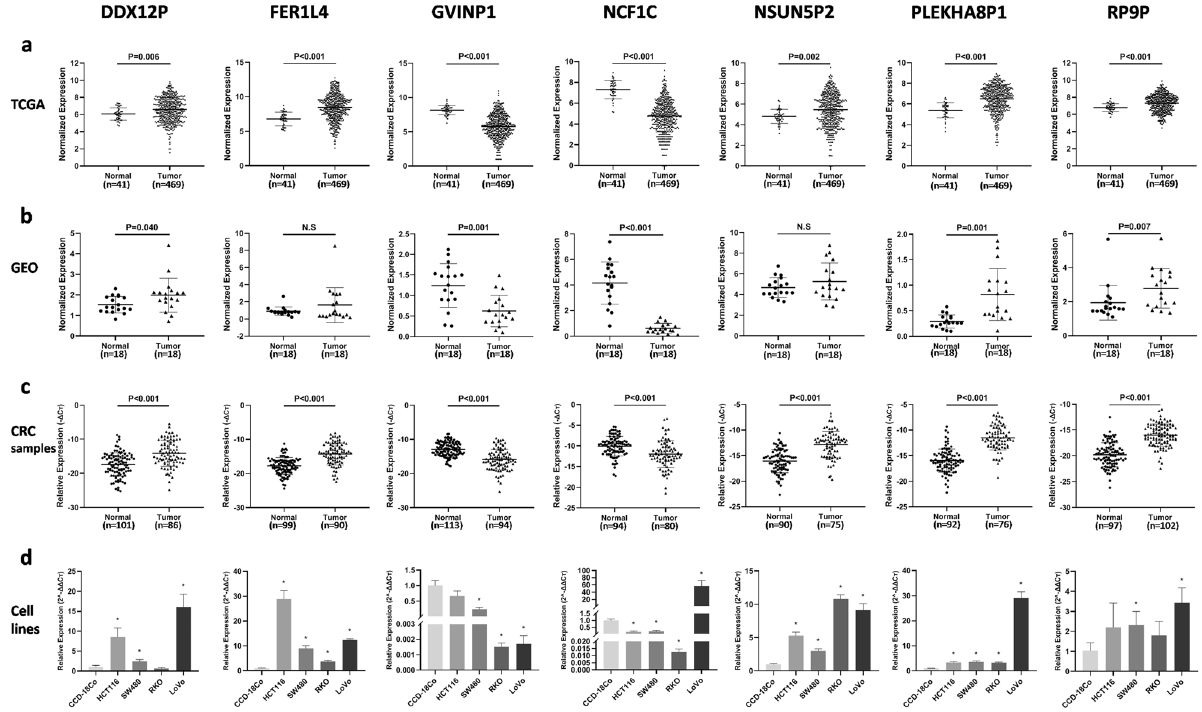
Figure 6. The expression levels of the 7 survival ‐ related DE pseudogenes in different datasets. ( a ) In normal colon tissues and colon cancer in TCGA. ( b ) Normal colon tissues and paired colorectal cancer in GSE50760 dataset of GEO. ( c ) In colorectal cancer tissues and paired normal tissues collected in our hospital, measured by